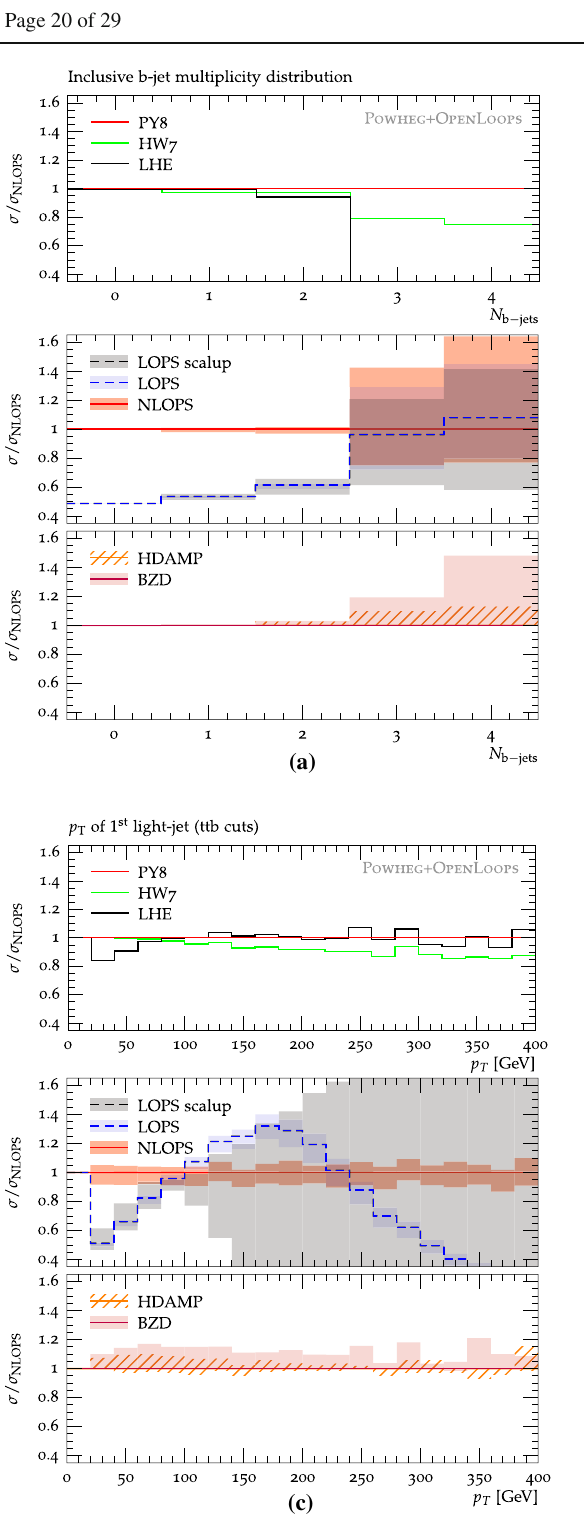
Fig. 9 Relativeimpactofshowereffectsanduncertaintiesin(N)LOPS tral frame compares NLOPS (red) and LOPS (blue) predictions with √ s =13TeV: distributions in the inclusive uncertainties related to α S variations and to the modelling of g → b ¯ b simulations of pp → t ¯ tb ¯ b at number of additional b -jets ( a ), the p T of the first b -jet ( b ) and the splittings in Pythia (red NLO band and blue LO band). At LOPS, also variations of the shower starting scale scalup = H T / 4 , H T / 2 , H T first light jet ( c ) with ttb cuts, and in the p T of the second b -jet with ttbb cuts ( d ). All results are normalised to nominal NLOPS predictions are shown (grey band). The lower frame illustrates the relative effect with Pythia 8. The upper frame compares NLOPS result based on of h damp = H T , H T / 2 , H T , 1 . 5 m t variations (HDAMP) and h bzd = Pythia 8 (PY8) or Herwig 7 (HW7) against LHE results. The cen- 2 , 5 , 10 variations (BZD). Top quarks are kept stable